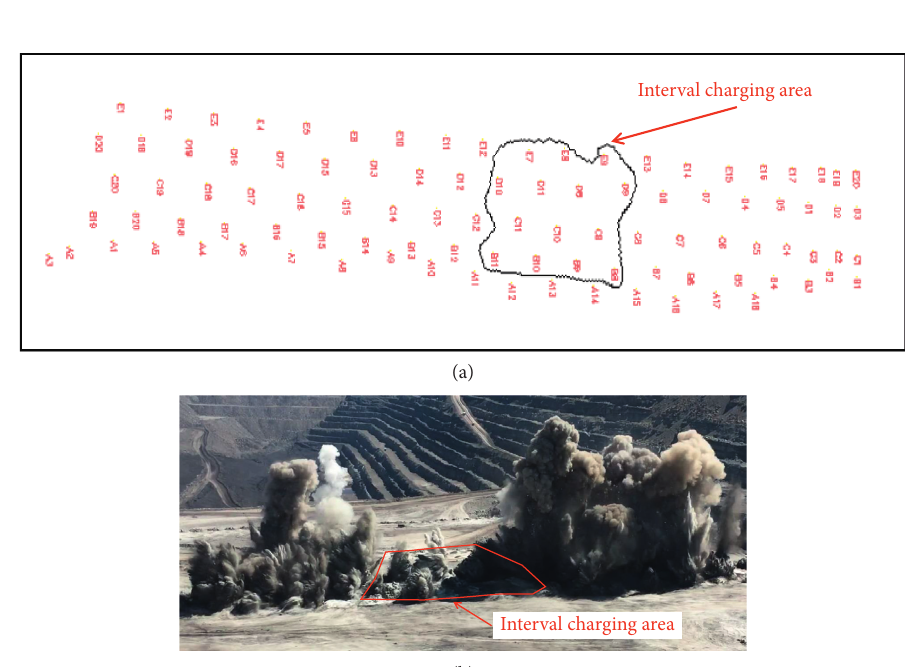
Figure 15: Comparison of punching in the blasting process. (a) Layout of blast holes in the explosion zone. (b) Blasting